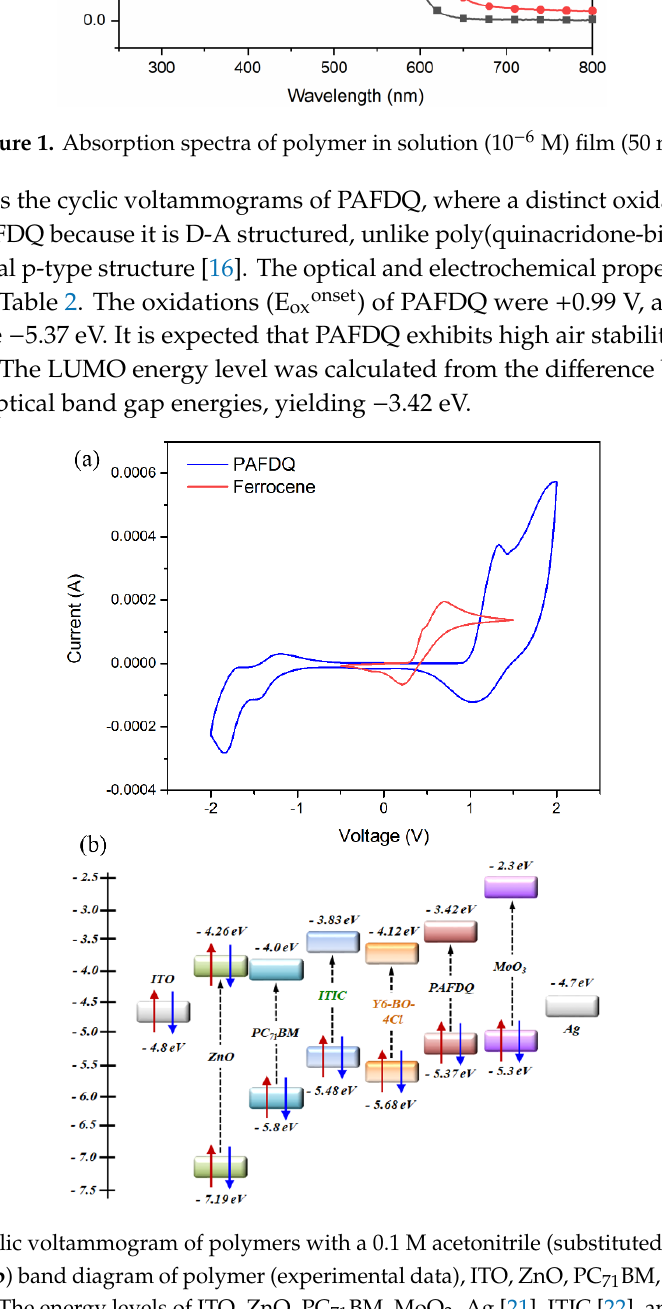
Figure 1. Absorption spectra of polymer in solution (10 −6 M) film (50 nm).